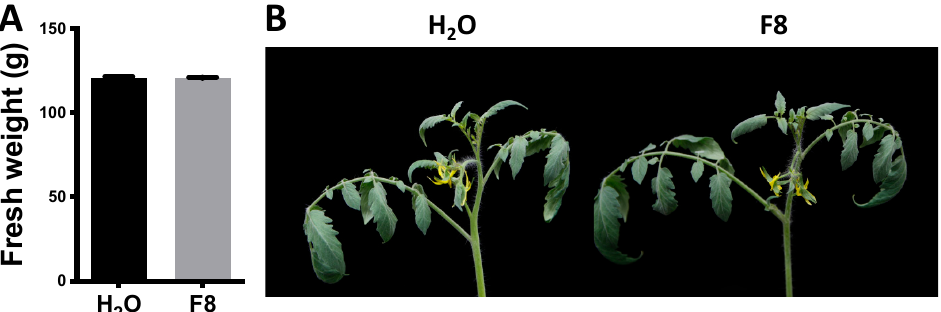
Figure 3. Fresh weight of Yu-Nu tomato with H 2 O or F8-culture filtrate pretreatment. ( A ) The average fresh weight was recorded for each treatment group ( n = 11). ( B ) The phenotype of H 2 O or F8-culture filtrate at 5 weeks post treatment.